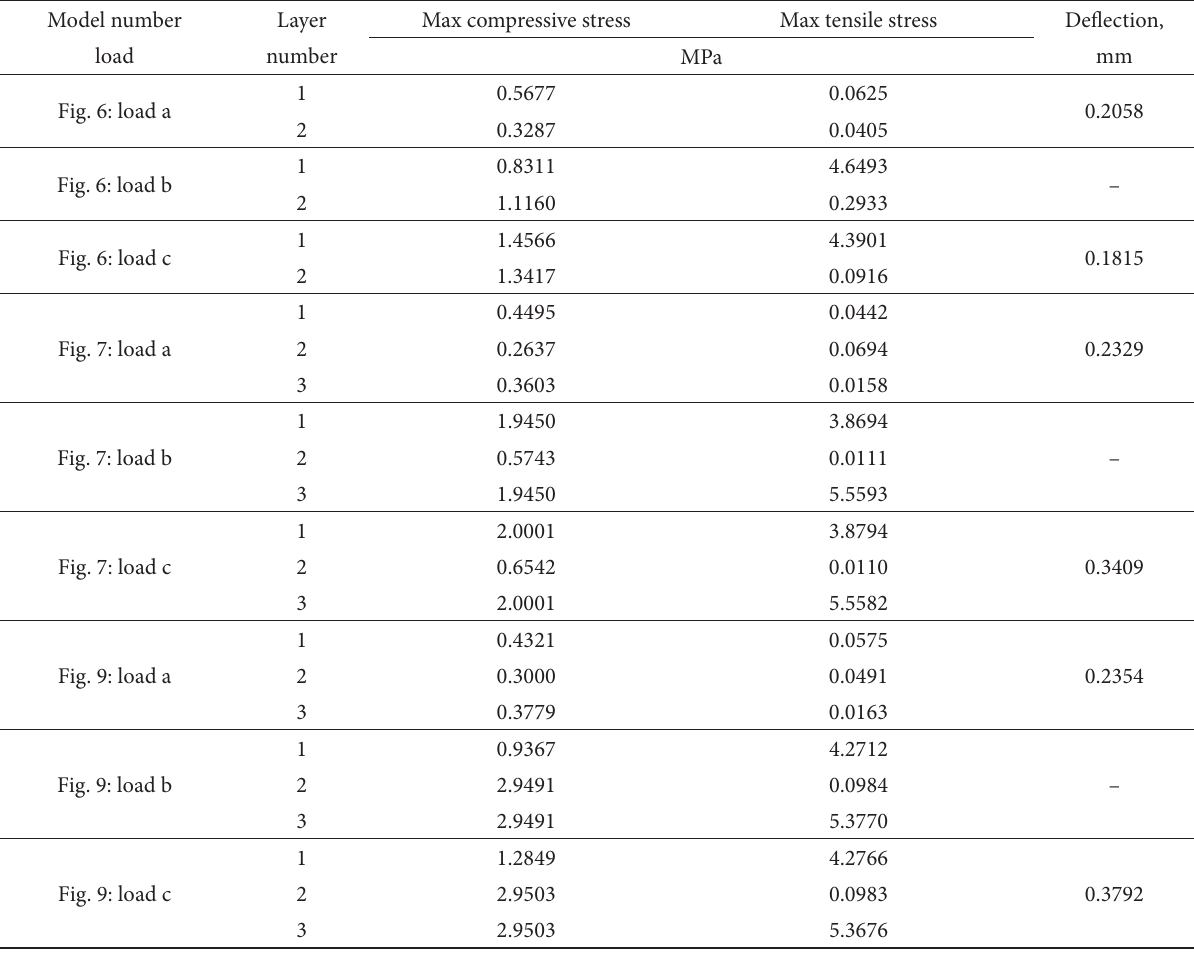
Table 4. Results of the mode of deformation research for schemes in Figs 6–9 Model number